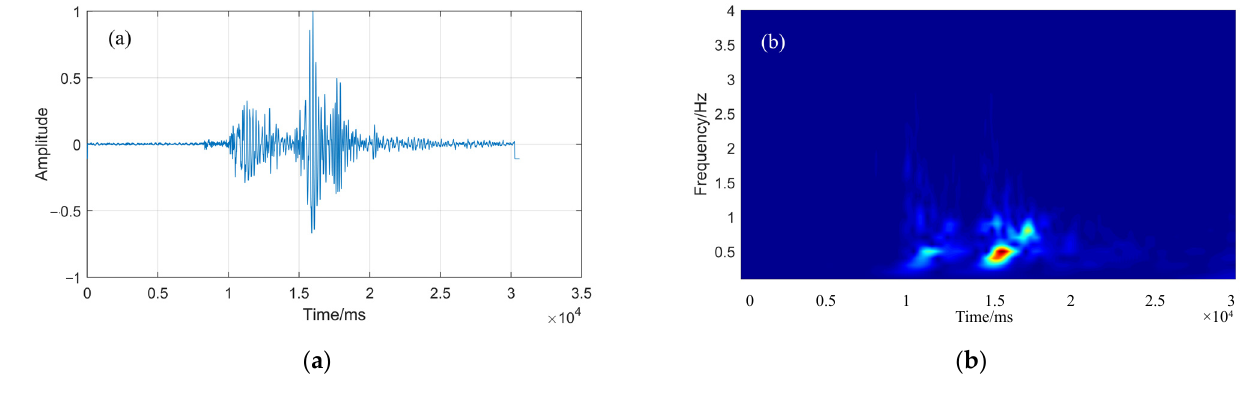
Figure 1. Microseismic waveform and time-frequency diagram. ( a ) the microseismic waveform diagram; ( b ) the time-frequency diagram.